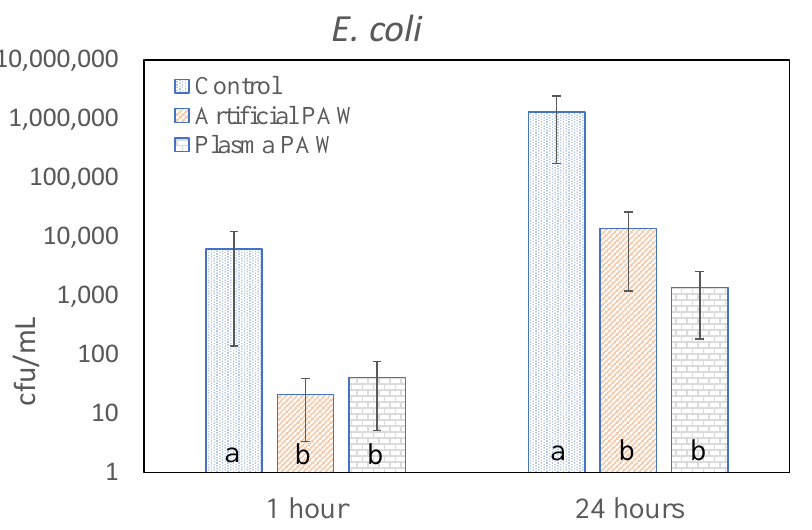
Figure 2. Inactivation of E. coli on inoculated wheat grains. Vertical bars indicate standard errors calculated from five parallel determinations. Significant differences at p < 0.05 are indicated by different letters. Separately determined results of PAW treatment after 1 h and 24 h are shown.